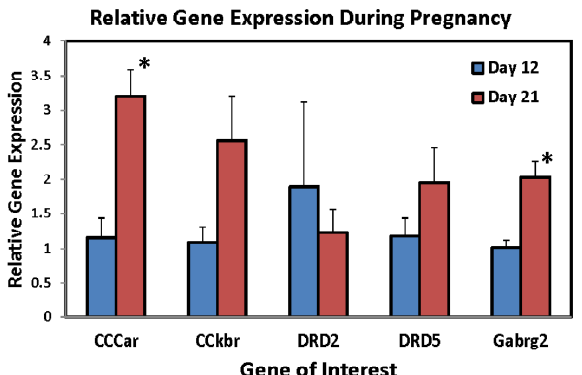
Figure 1. Relative mRNA expression levels of CCKar , CCKbr , Drd2 , Drd5 , and Gabrg2 genes in the ventromedial nucleus of the hypothalamus (VMH) following RT-PCR in primigravid rats on either day 12 ( N = 5/group) or day 21 ( N = 6/group) of gestation. * Significantly different from day 12 of gestation, p <